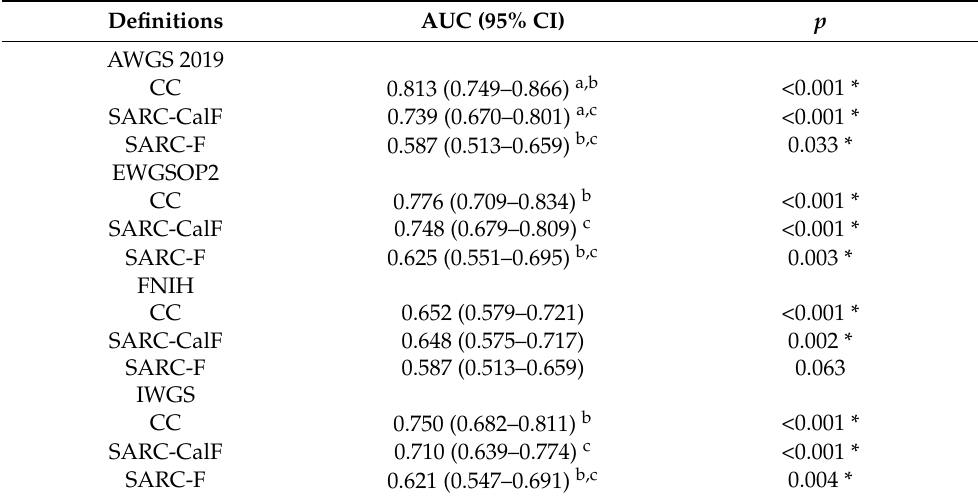
Table 4. The diagnostic performance of SARC-F, SARC-CalF, and CC on sarcopenia based on four operational definitions in the overall study population.